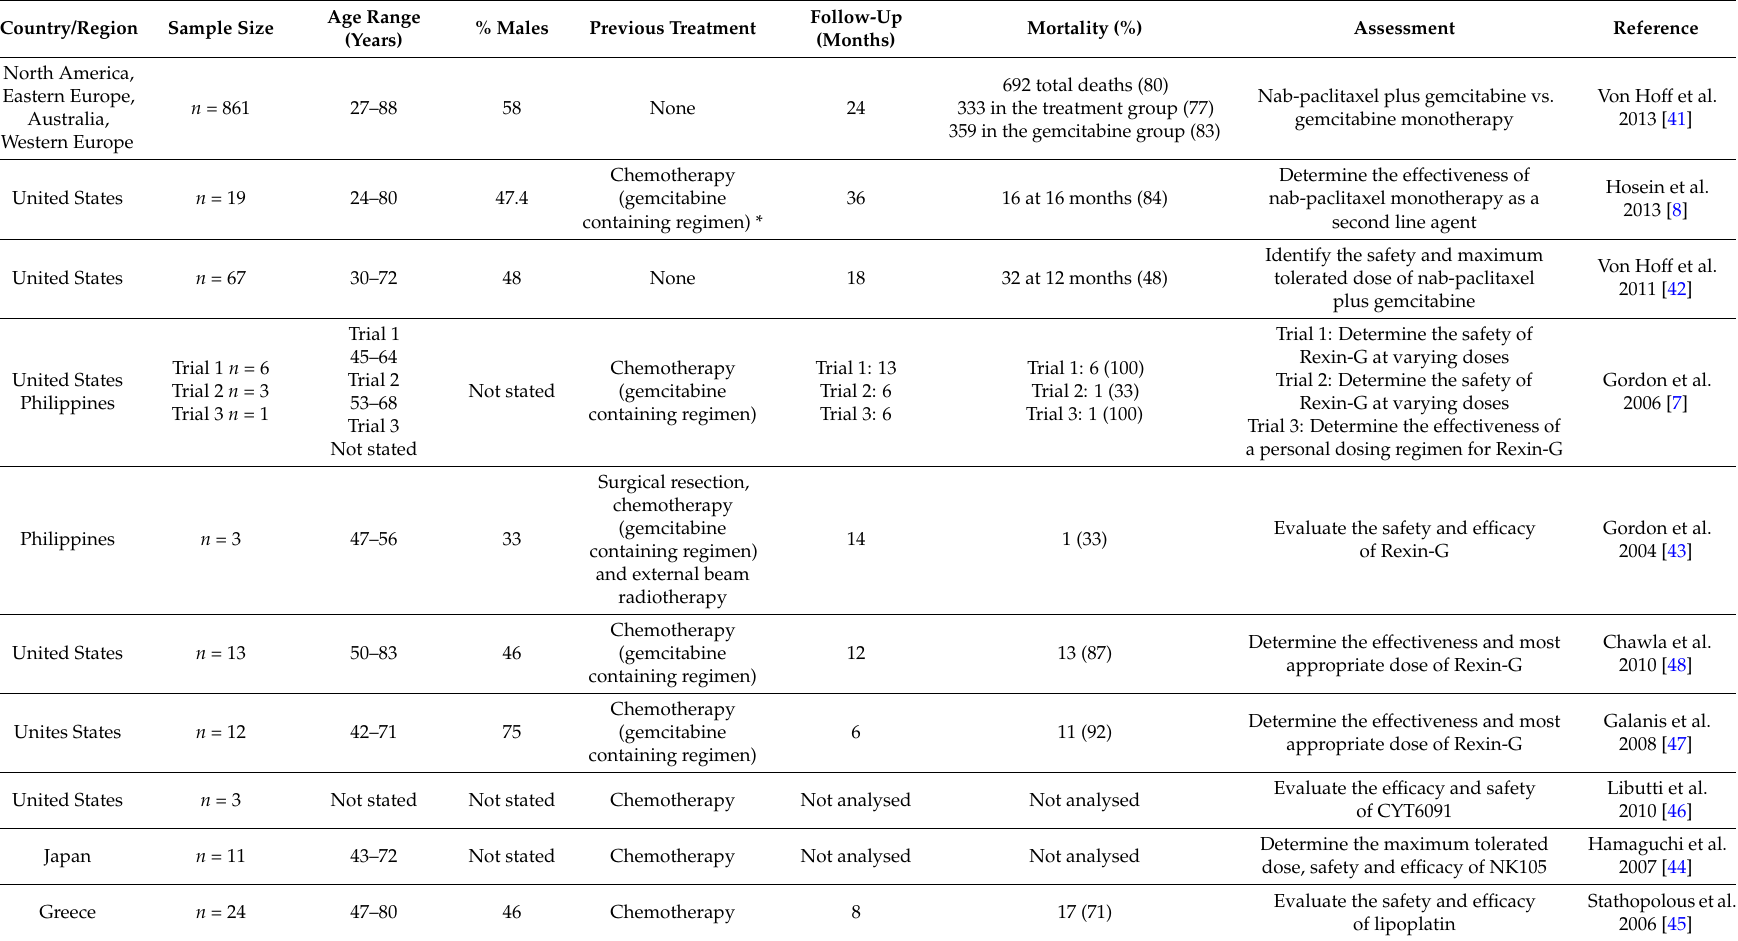
Table 1. Characteristics of included